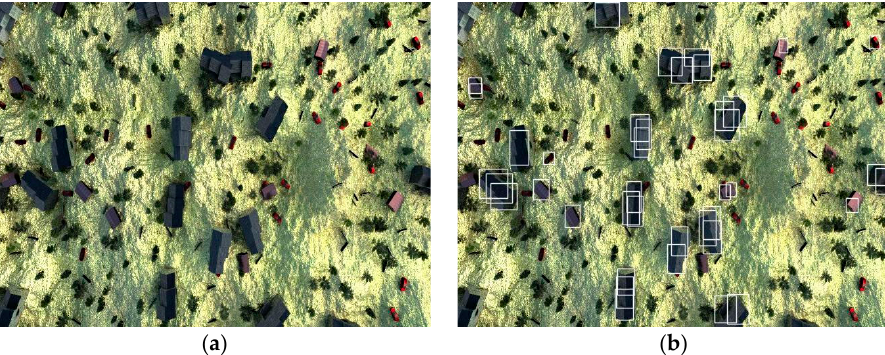
Figure 10. ( a ) Simulated UAV original image. ( b ) Detection of “buildings” using RetinaNet, marked in white boxes.